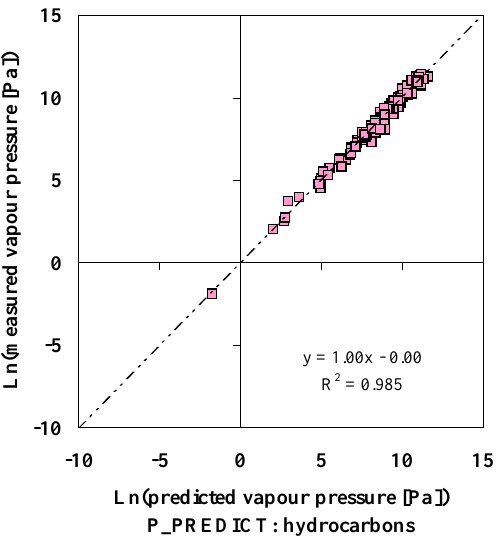
Figure 6. Test of P_PREDICT. Model for aliphatic hydrocarbons. Prediction of ln p from the compounds’ chemical (UNIFAC) structure. The line, which fits the data best, is of the general form: y = (1.00 ± 0.01) x - ( 0.00 ± 0.05). n = 118. Average bias of prediction is: – 8.0 10 -7 , SEP is 0.27, and RMSEP is 0.27 log units.